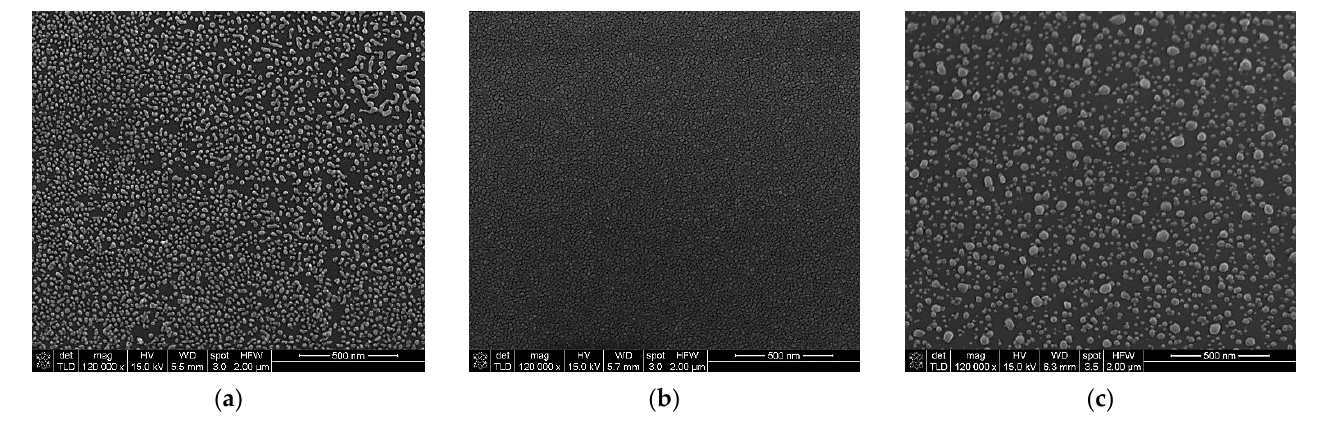
Figure 4. SEM micrographs of a 2 nm metallic (mass equivalent): ( a ) Au, ( b ) Al, ( c ) Ag. On top of the metallic nanostructures, layers of PMMA doped with R6G in three different concentrations were deposited. Figure 5 shows the fluorescence intensity of R6G in the presence of metallic metasurfaces in comparison with the reference. In the inset of the figures, a graph in the logarithmical scale is presented in order to show the magnitude orders. The improvement of fluorescence by Au metasurfaces is small for lower concentrations of fluorophores in the PMMA layer (Figure 5a). Only for high concentrations of R6G in PMMA (C 1 ) was a significant improvement of fluorescence emission observed. The same behaviour can be seen in the case of Ag metasurfaces (Figure 5c). In the case of aluminium metasurfaces, the concentration has a very low influence on the improvement of the fluorescence emission (Figure 5b). This is due to the really thin nanostructures (hights between 3 and 5 nm, see Table 3) that can accommodate, nearby, only a limited number of fluorophore molecules, approximatively independent of the dye concentration. The advantage of these Al structures is that they offer the best improvement of fluorescence intensity for the thinnest layers of fluorophore dispersed in PMMA. ( a ) ( b ) ( c ) Figure 5. Florescence intensity enhancement by a 2 nm metallic (mass equivalent) films on silicon substrate (inset are the FLEN with logarithmic y scale): ( a ) Au meta-atoms; ( b ) Al meta-atoms; ( c ) Ag meta-atoms. Figure 6 shows a comparison of the fluorescence emission obtained with the three types of metal layers and bare silicon as a reference. The compared results were obtained for R6G:PMMA layers of the same thickness (deposited with an 6000 rpm rate for 40 s) and concentration (C 3 ). These layers were selected to demonstrate that we can achieve important fluorescence enhancement for low dye concentrations in thin films. It can be seen that the metasurface with Al elements offers the best response in fluorescence compared to other metals. FLEN is influenced by the distance between the aluminium